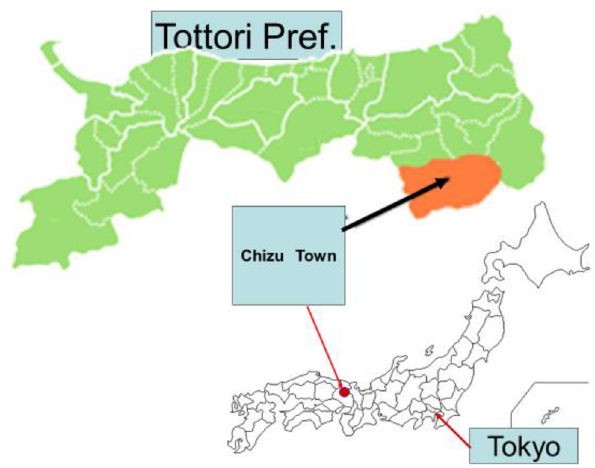
Fig. 3 Location of Chizu Town, Tottori Prefecture, Japan. Source http://www1.town.chizu.tottori.jp/dd.aspx?menuid=1